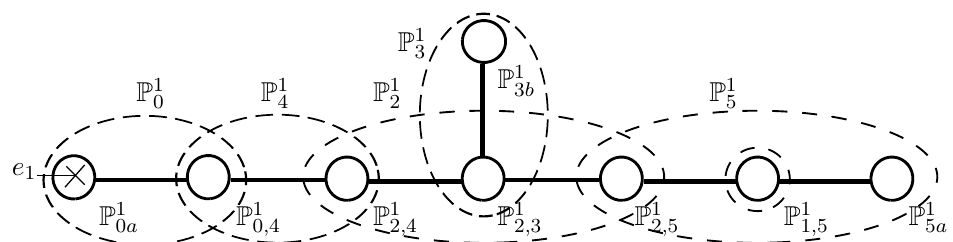
Figure 9 . Extended Dynkin diagram of E 16 16 10 (cid:0) 1 = 4 (cid:0) 1 = 2 ; the a(cid:14)ne node intersects with [ e 1 ], the dashed ellipses indicate the SO(10) 3 = 4 before the matter splits.